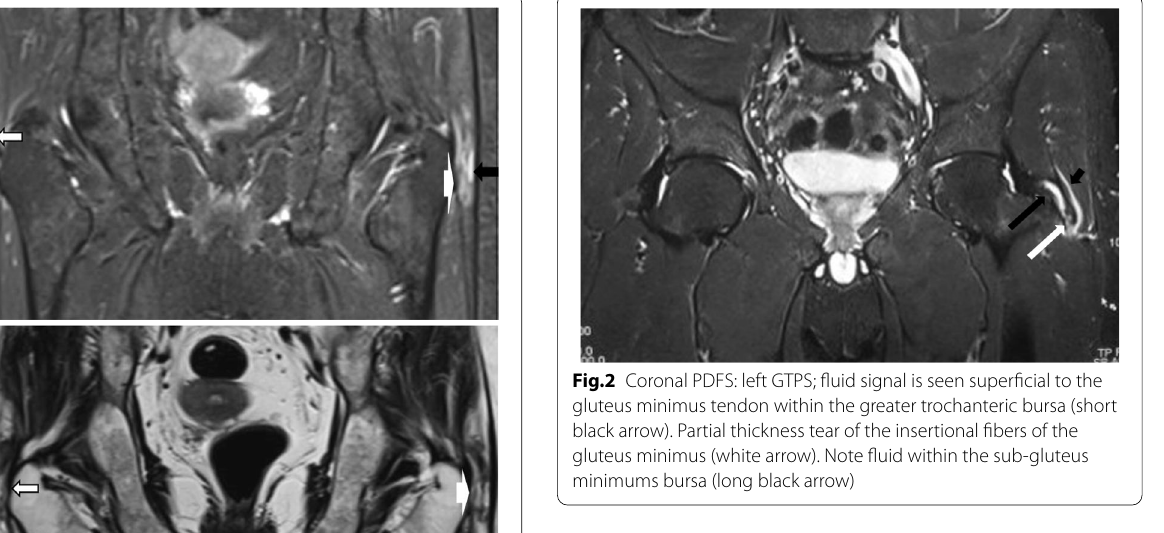
SPSS software package (v. 20, Chicago, IL). Statisti- cal analysis was expressed in terms of mean, standard deviation (SD), minimum, and maximum. The statisti- cal significance of differences in sex and GTPS signs on MRI was calculated using the chi-square test.